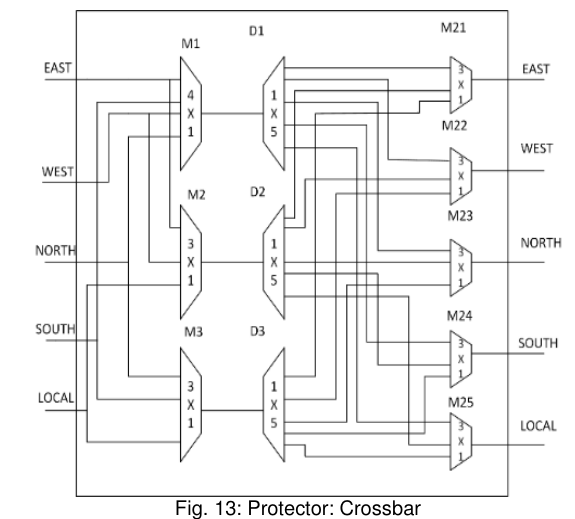
Fig. 13: Protector: